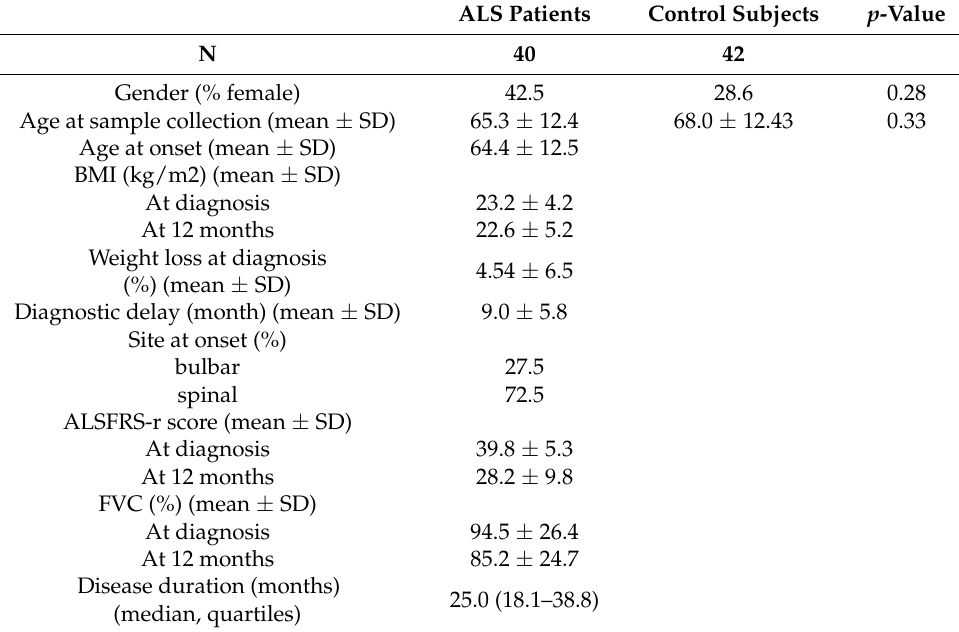
Table 1. Characteristics of ALS patients and controls.